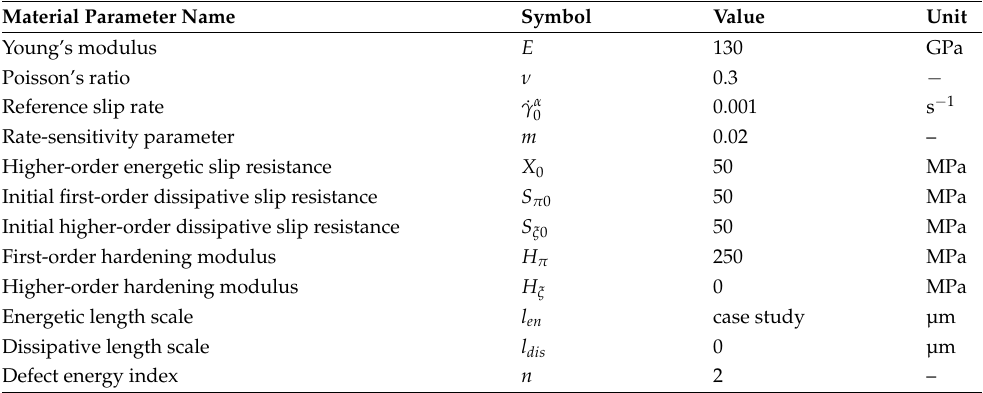
Table 2. Material parameters implied for the simple shear of a constrained layer undergoing finite deformation, inspired by [49].